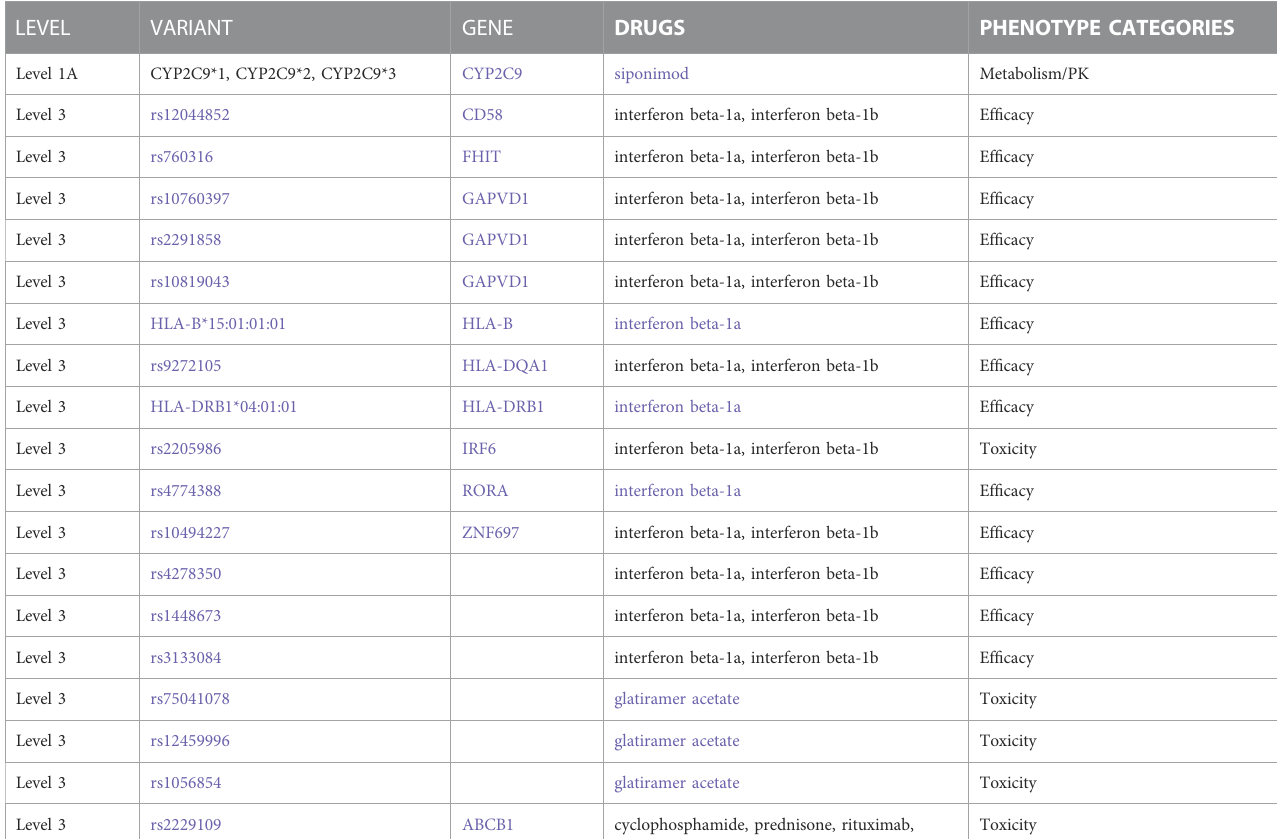
TABLE 2 Genetic variants implicated in ef fi cacy and safety of MS